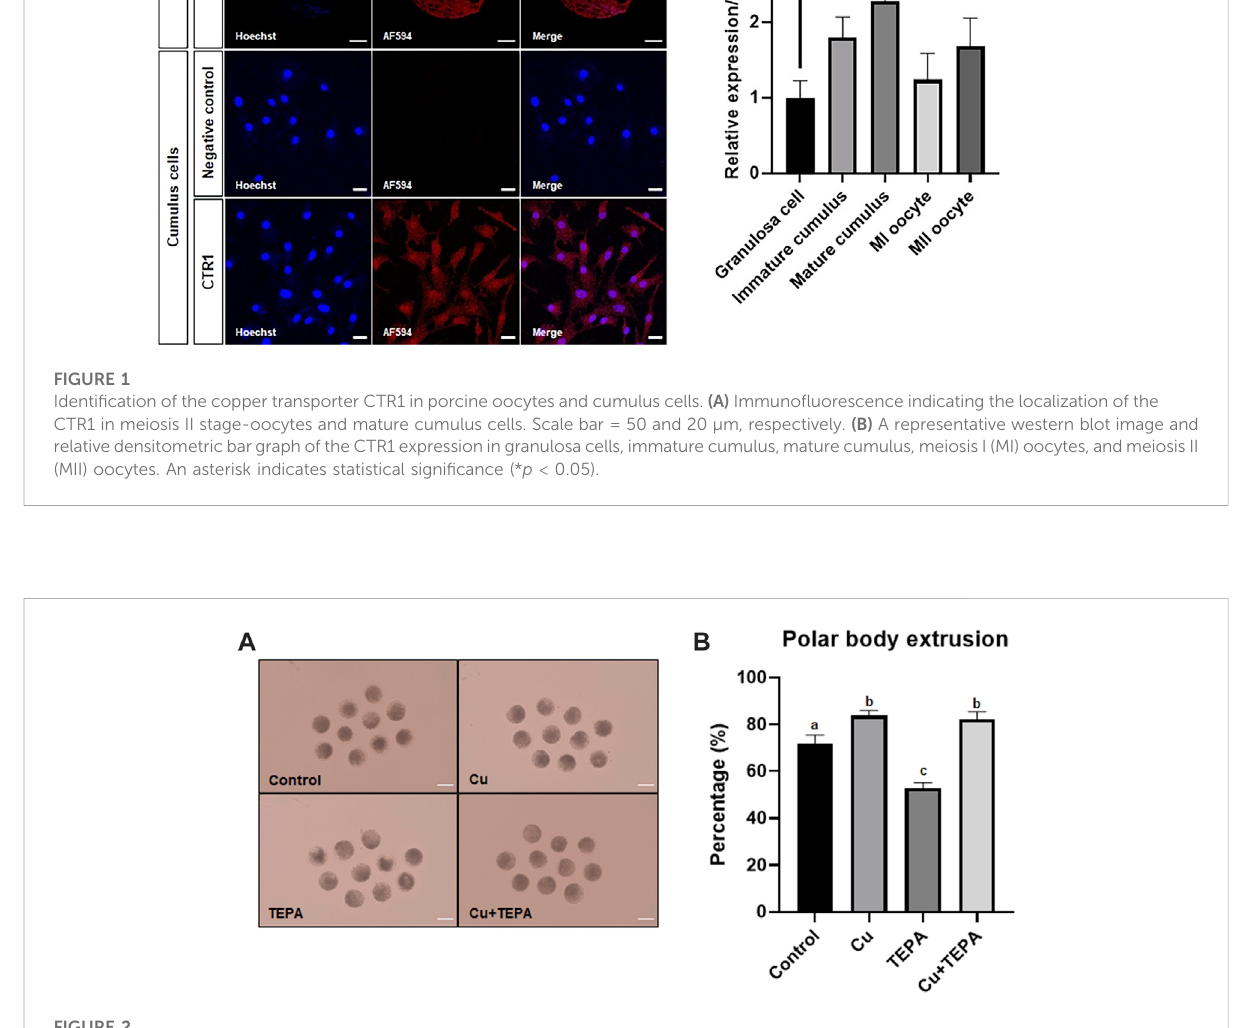
FIGURE 2 Effect ofCu chelation onthe fi rst polar bodyextrusion rate of invitro matured oocytes. (A) The imagesofmatured oocytes for each group. Sale bar = 100 μ m. (B) A rate of polar body extrusion after Cu and TEPA supplementation during 42 h of IVM. The values represent the mean ± SEM. The values (a – c) with different superscripts within the same column are signi fi cantly different ( p < 0.05). The experiment was replicated